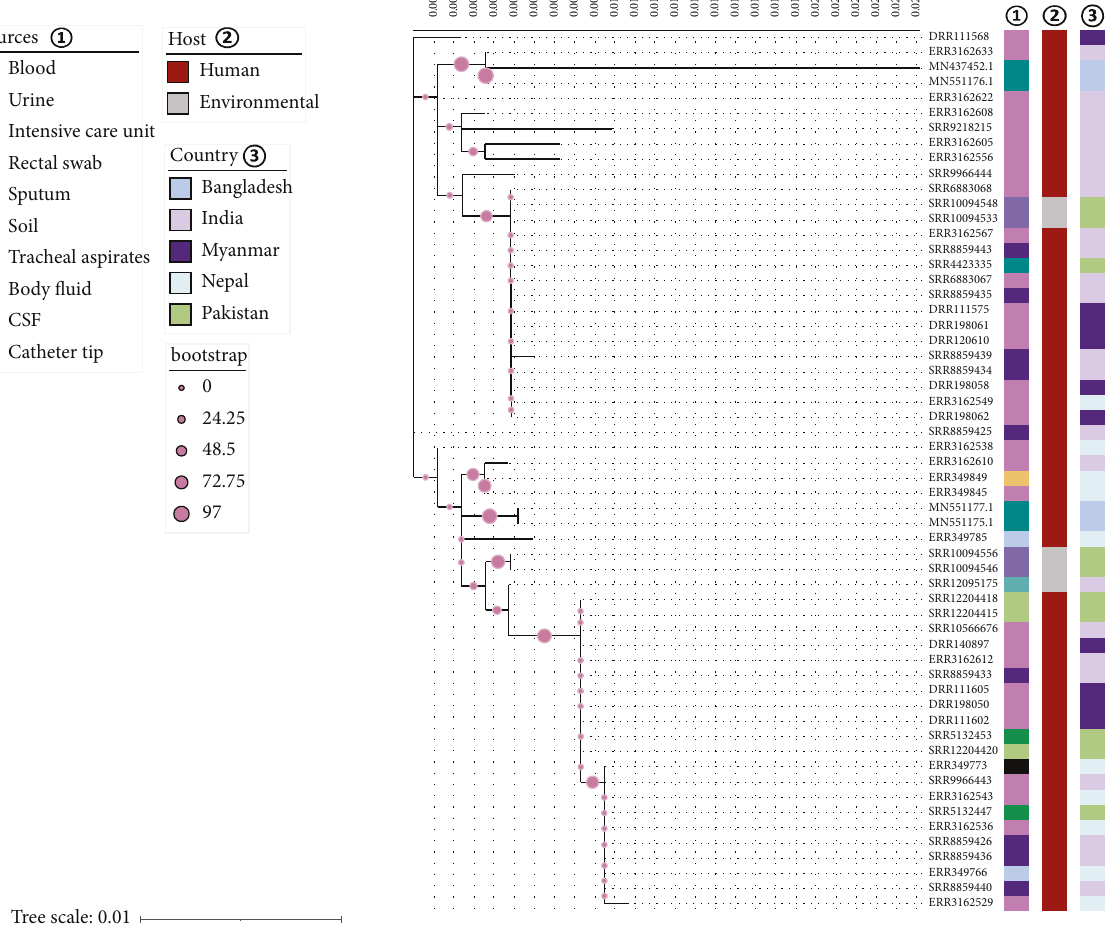
Figure 4: Molecular Phylogenetic analysis of SHV-11 protein. The evolutionary history was inferred by using the maximum likelihood method based on the HKY model. Here, the tree was built with the bootstrap value (100). The tree was drawn to scale, with branch lengths measured in the number of substitutions per